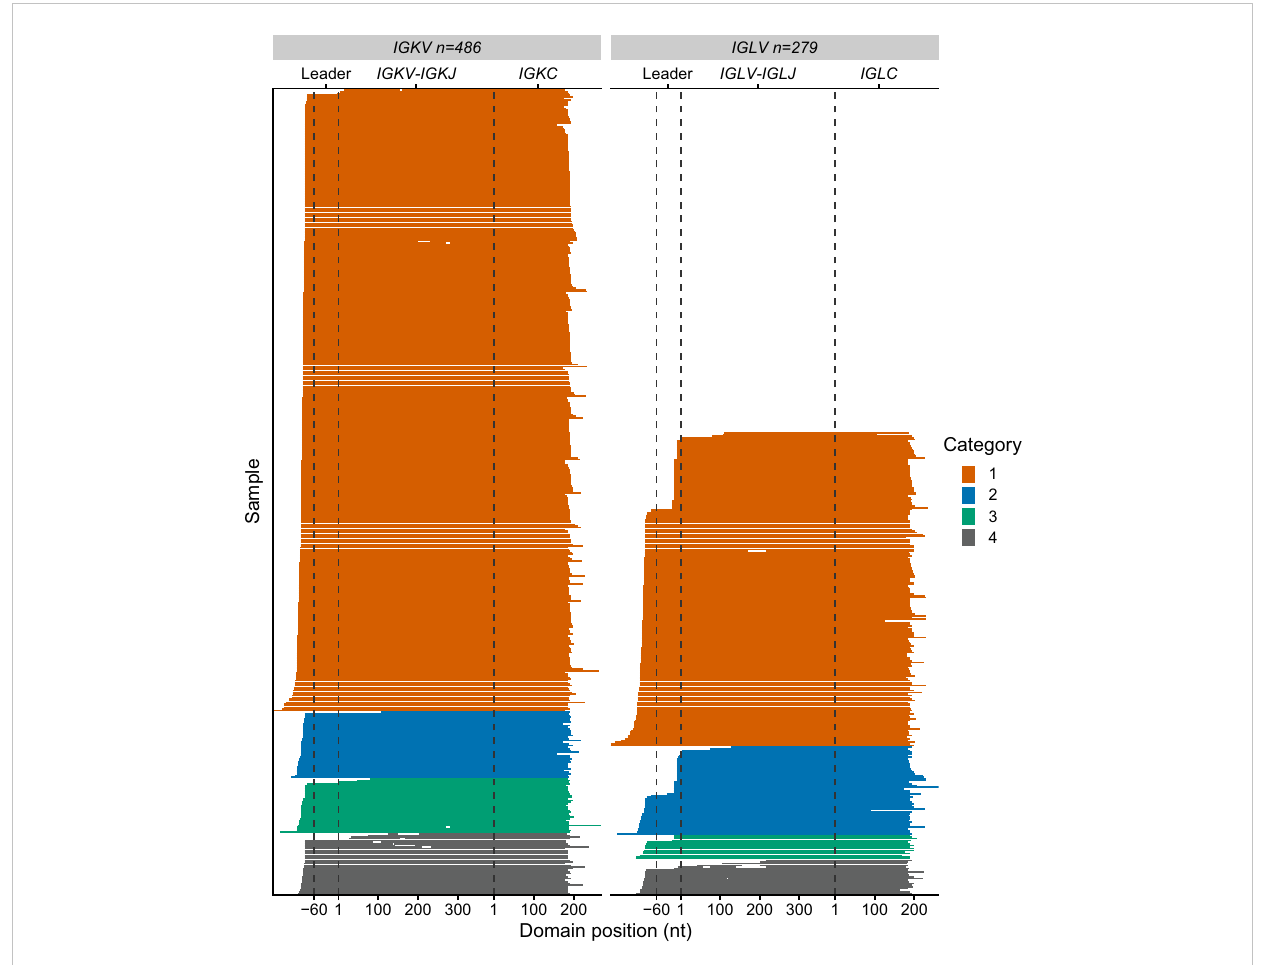
FIGURE 6 Sequence coverage for 765 IGV L -IGJ L clones. Each horizontal line represents a single clonotype sequence determined by MiXCR. Sequences are aligned according to the start of the IGV L and IGC L regions, which were identi fi ed by alignment to IMGT reference sequences. Gene regions are indicated with dashed lines. The fi rst nucleotides of the IGKV / IGLV and IGKC / IGLC genes are used as reference points. Gaps represent regions of missing sequence; the differences in IGV L -IGJ L length between different germline genes are not shown. Colors represent the category to which each sequence is assigned, as for Figures 4,